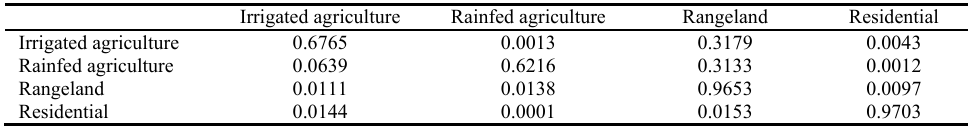
Table 5: Transition probability matrix for LUCC modeling based on the 1987-2009 calibration period